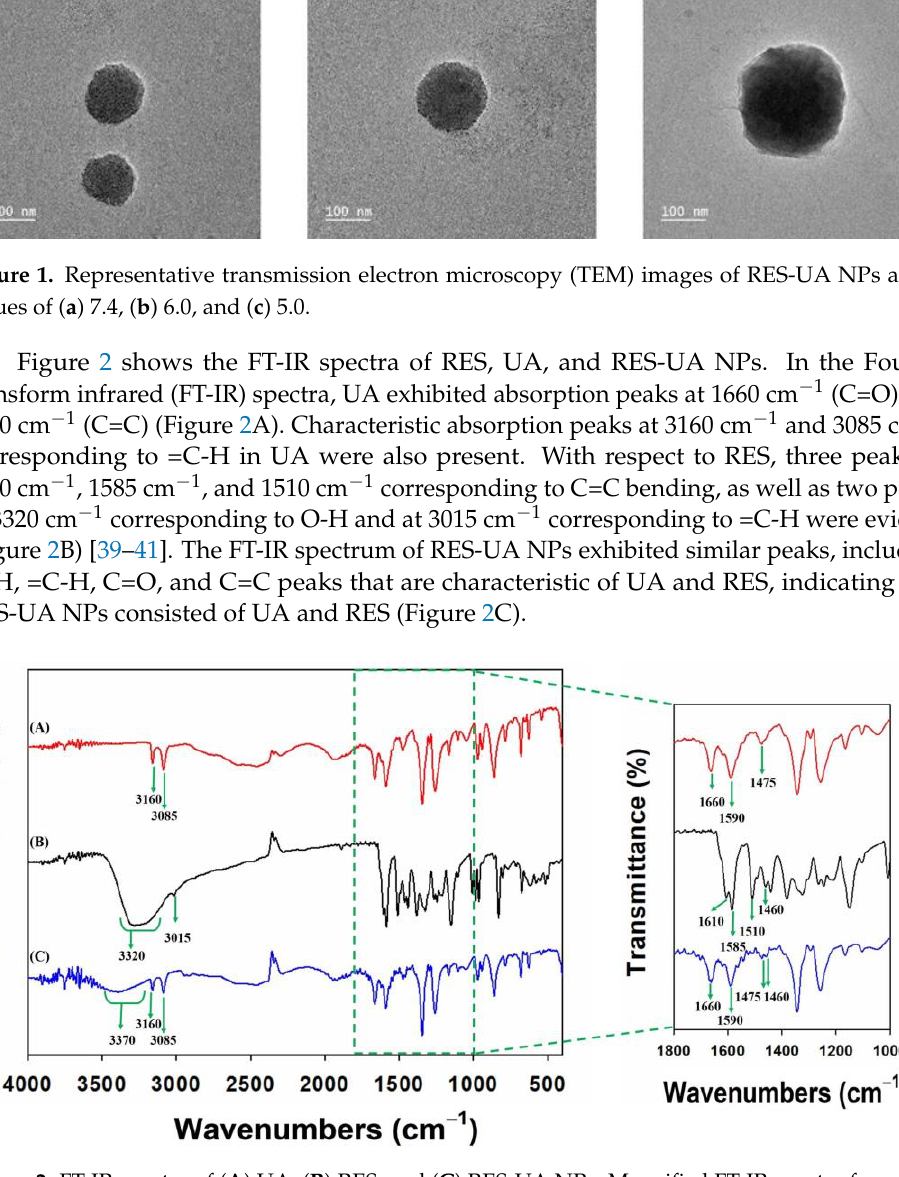
Figure 2. FT-IR spectra of ( A ) UA, ( B ) RES, and ( C ) RES-UA NPs. Magnified FT-IR spectra from 1800 to 1000 cm − 1 .